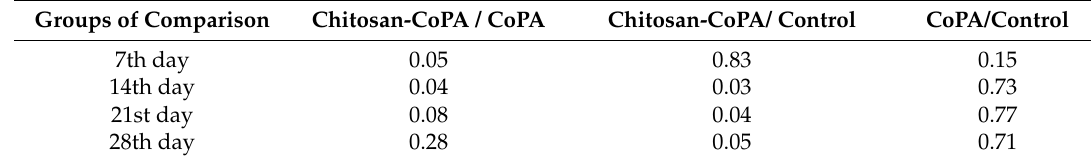
Table 2. P -values for group comparisons.